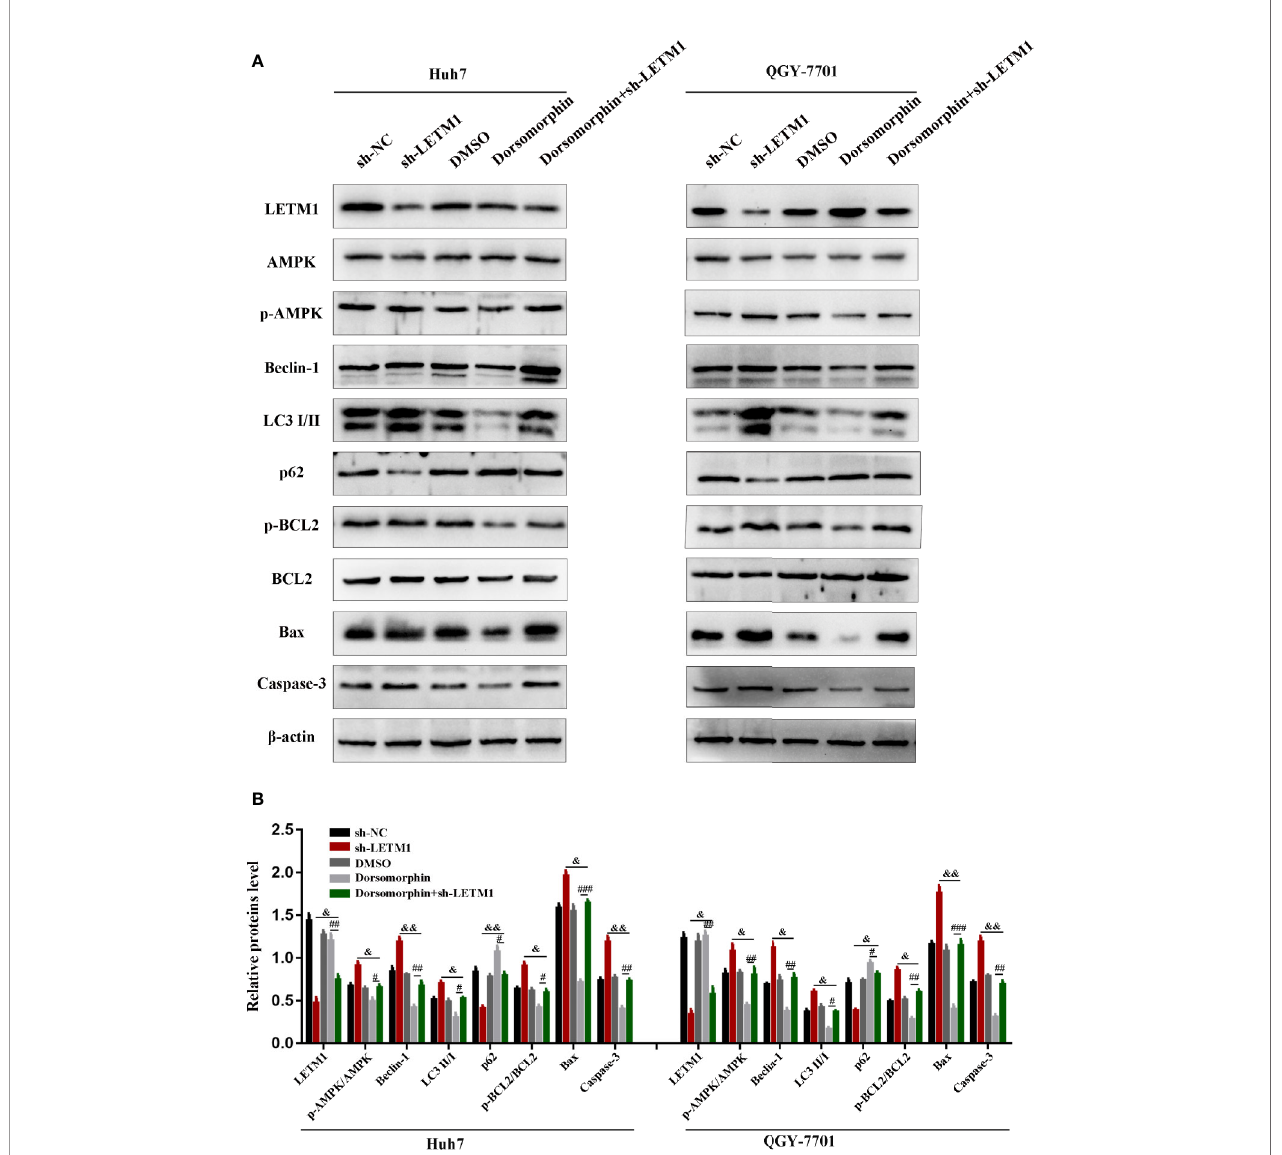
FIGURE 4 | Knockdown of LETM1 regulates autophagy and apoptosis through activating AMPK. (A, B) Western blot analysis of the expressions of autophagic associated proteins (Beclin1, p62, and LC3), apoptotic-related proteins (p-Bcl-2, Bcl-2, Bax, caspase-3), LETM1, and AMPK in LETM1-knockdown along with AMPK inhibitor Huh7 and QGY-7701 cell lines. # p < 0.05, ## p < 0.01, ### p < 0.001 means dorsomorphin versus LETM1 shRNA+dorsomorphin group; & p < 0.05, && p < 0.01, means LETM1 shRNA group versus LETM1 shRNA+dorsomorphin